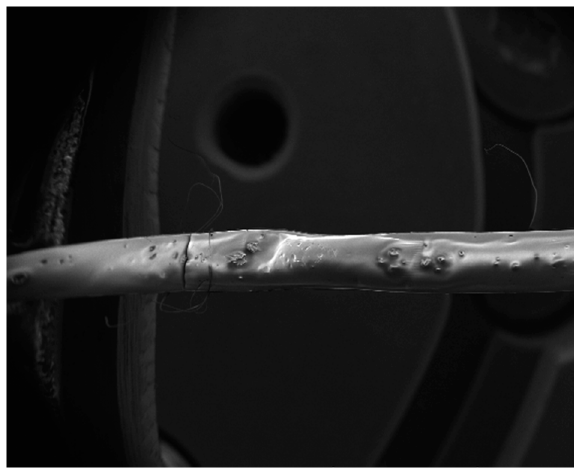
Figure 3. Electron micrograph of a dextran coated Parylene-C neural probe. A crack can be seen on the left-hand side of the probe which was formed after buckling. Reproduced with permission from [31]; published by IOPscience, 2017.